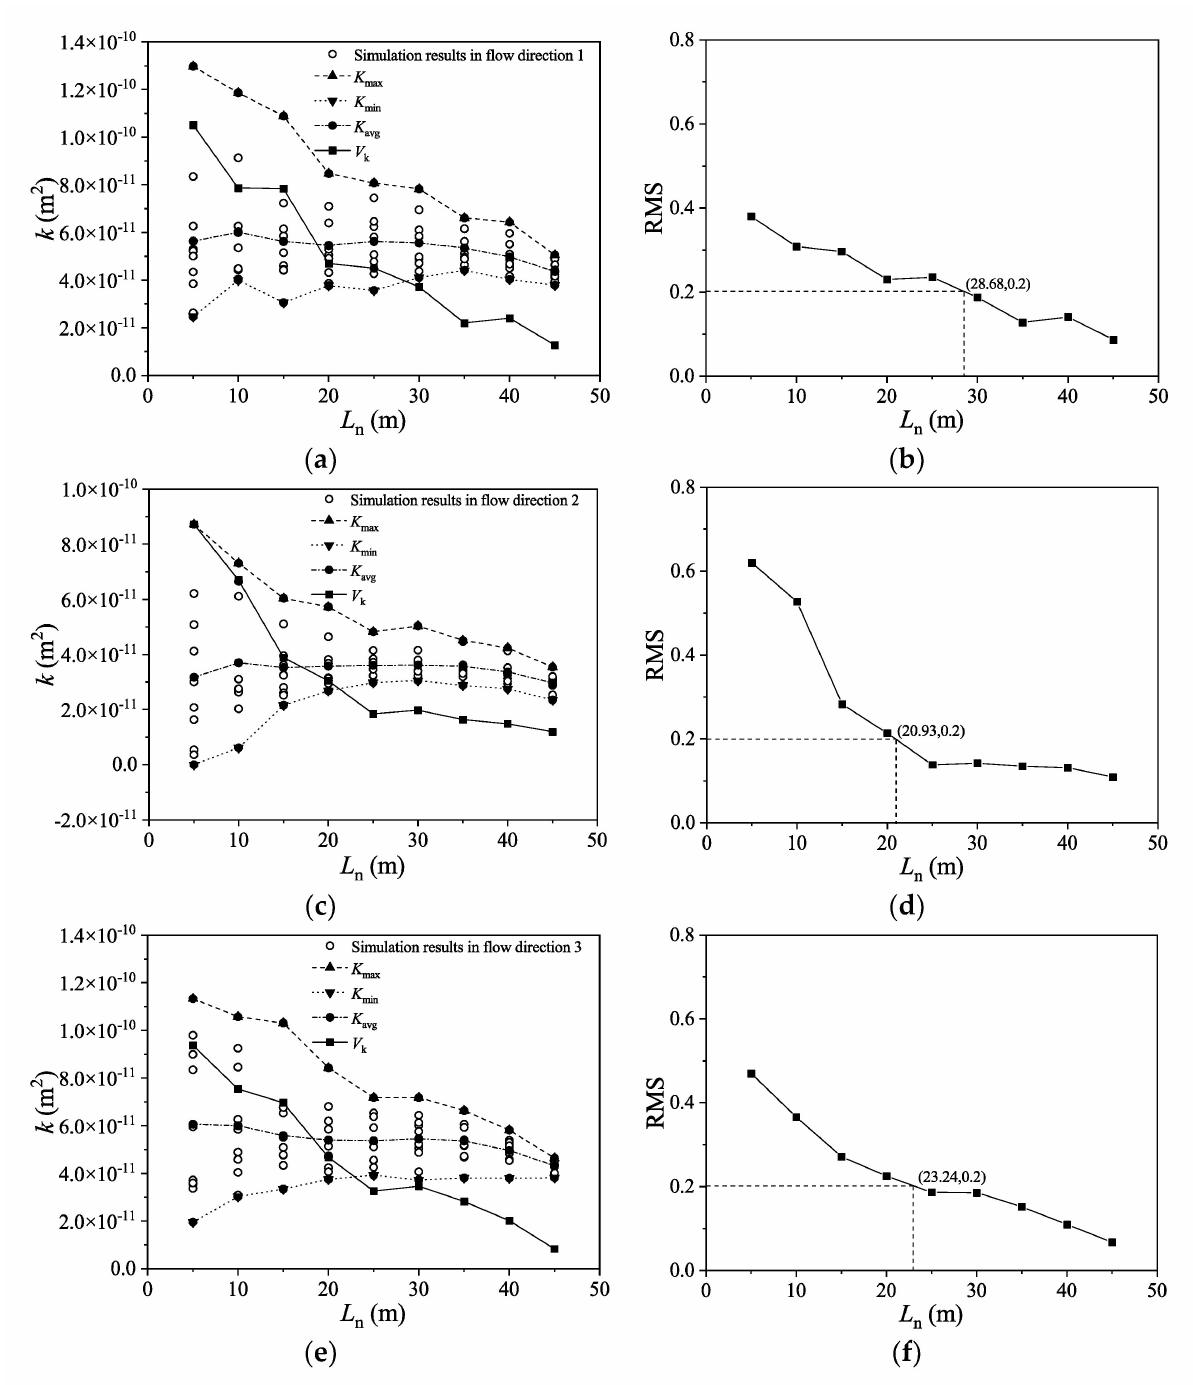
Figure 14. Variations in k and RMS with increasing L n in three flow directions. ( a ) Variations in k in flow direction 1; ( b ) Variations in RMS in flow direction 1; ( c ) Variations in k in flow direction 2; ( d ) Variations in RMS in flow direction 2; ( e ) Variations in k in flow direction 3; ( f ) Variations in RMS in flow direction